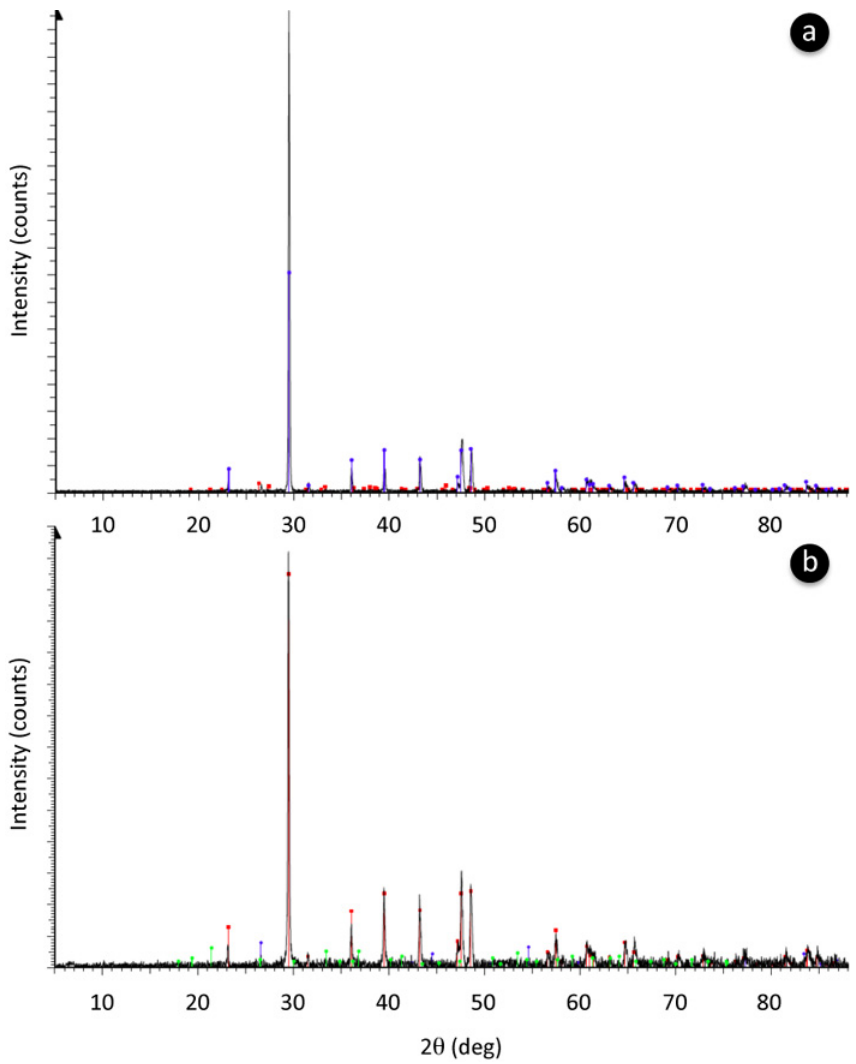
Fig. 7. XRD analyses of various zones of stalactite show that (a) the thick and thin layers consist mainly of calcite, and that (b) dark-brown crusts are amorphous as calcite is the only mineral present in the